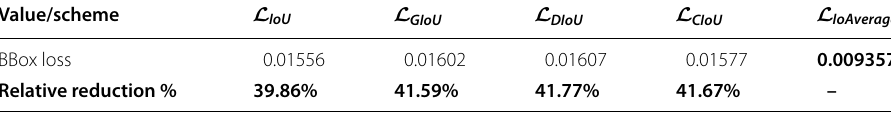
Bold indicates the results obtained by calculating the BBox loss using the method proposed in this paper Relative reduction is calculated based on the bbox loss calculated by the IoAverage scheme